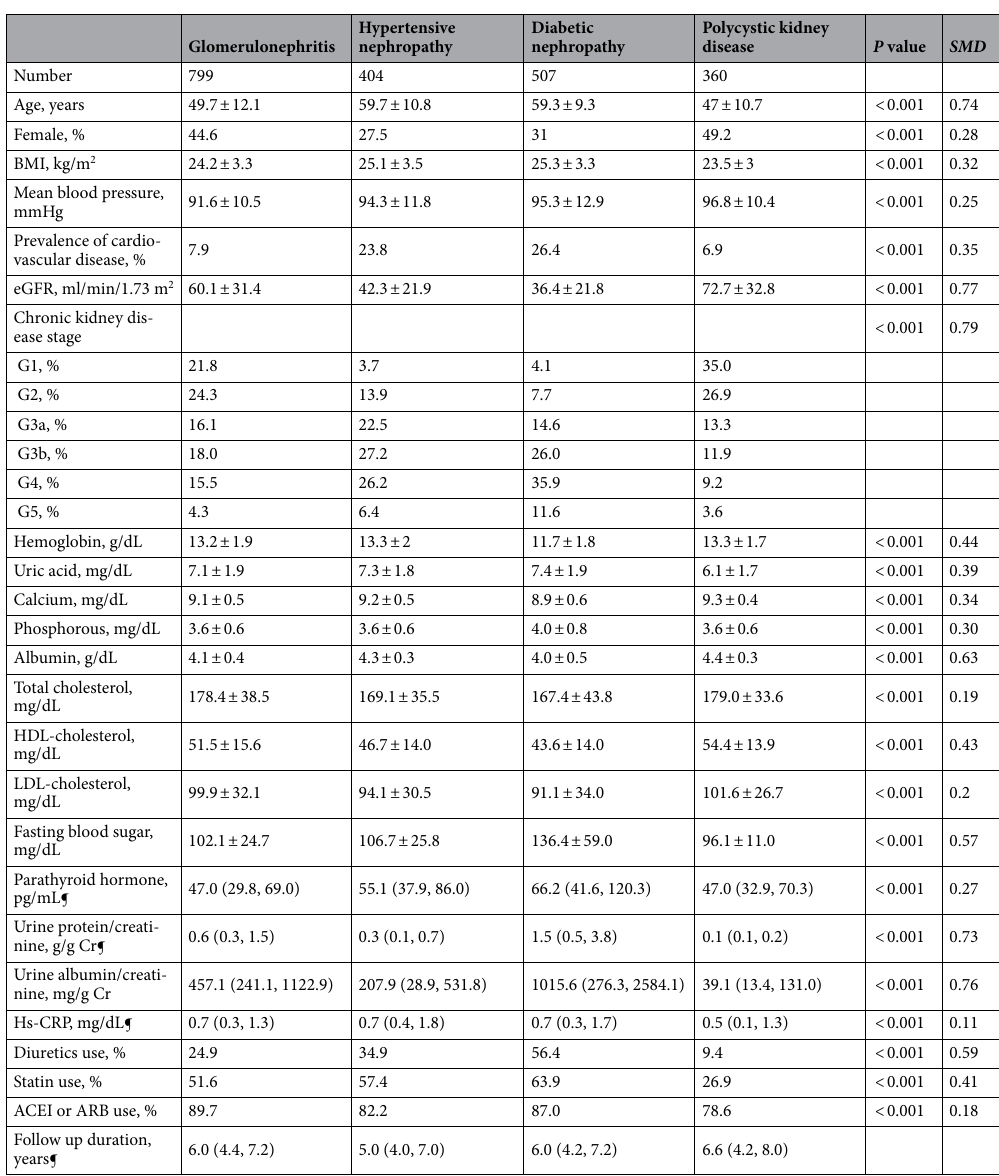
Table 1. Comparison of baseline clinical characteristics according to cause of chronic kidney disease before propensity score matching. ¶ Presented as Median (quartile 1, quartile 3) due to non-normal distributions. Otherwise, continuous variables are presented as mean ± standard deviation and categorical variables as proportion. ACEI, angiotensin-converting enzyme inhibitors; ARB, angiotensin-receptor blockers; BMI, body mass index; eGFR, estimated glomerular filtration rate; HDL, high-density lipoprotein; Hs-CRP, high sensitivity C-reactive protein; LDL, low density lipoprotein; SMD; standardized mean